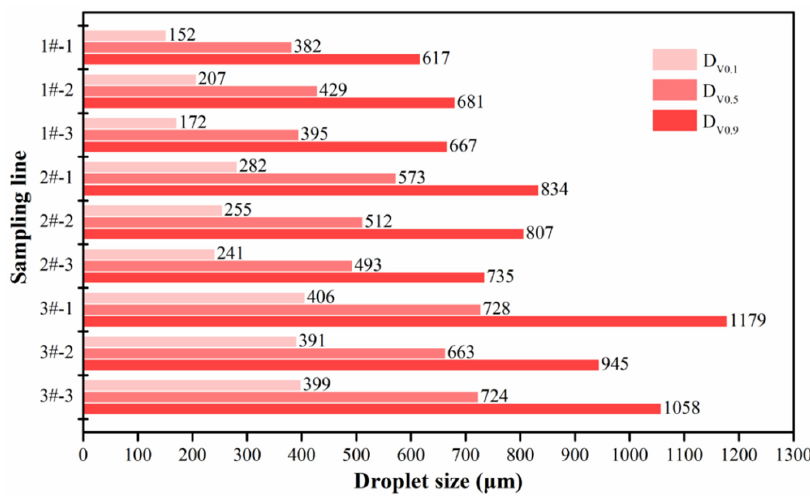
Figure 7. Droplet size distribution for each sampling line of each test.